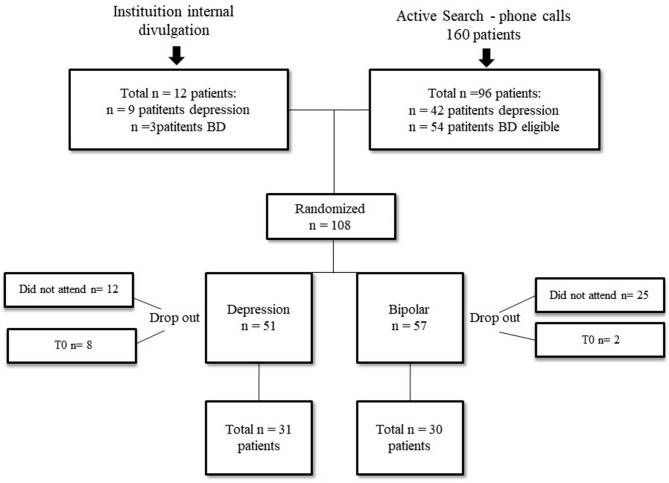
Patient flowchart.